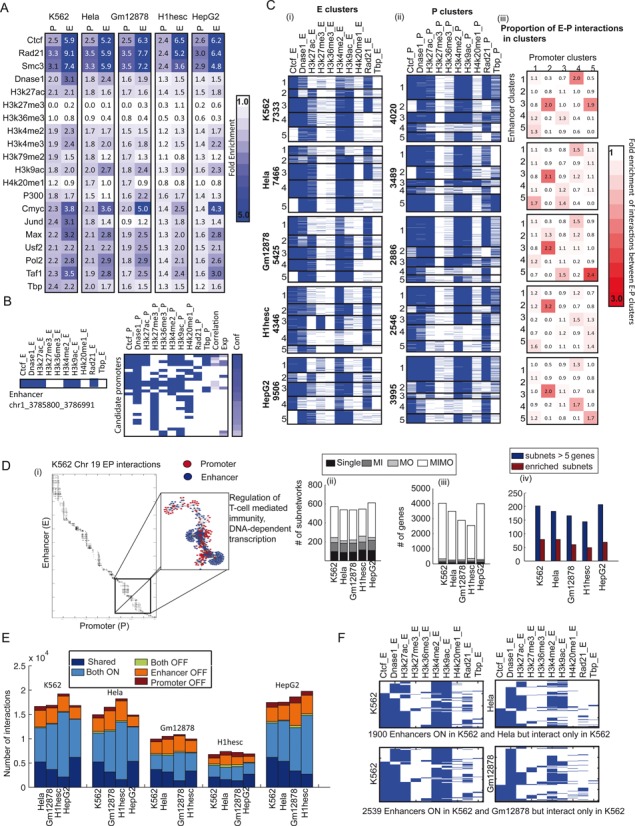
Properties of genome-wide enhancer-promoter interactions. (A) Enrichment of various individual genomic signals in the enhancers and promoters in the high confidence networks. The stronger the intensity of blue the better the enrichment. (B) Example of an enhancer from the K562 cell line and candidate promoters that are in its 1 MB radius. The promoters are ranked by RIPPLE confidence (Conf; min 0.5). The _E and _P features are binary (0: white, 1: blue), while the Correlation and Expression (Exp) features are continuous. (C) Clusters of enhancers and promoters in the five cell lines. (i) Enhancer clusters, each cluster is numbered 1–5, and the number of enhancers are shown on the side. (ii) Promoter clusters, numbered 1–5, with the number of promoters in each cluster shown on the side. Blue indicates the presence of a feature and white indicates absence. (iii) Fold enrichment of interactions between an enhancer cluster (row) to a promoter cluster (column) compared to the expected number of interactions between these clusters. The more red the intensity the greater is the tendency for enhancers from one cluster to interact with promoters from another cluster. (D) Enhancer-promoter interaction landscape for Chromosome 19 in K562. (i) The enhancer-promoter interactions for subnetworks extracted from a connected components analysis. The blow-up shows an example set of promoters regulated by multiple enhancers and enriched for transcriptional as well as immune response processes. (ii–iv), Distribution of enhancer-promoter interactions in different types of subnetworks. The majority of the interactions are in the multi-input multi-output subnetworks. Subnetworks are enriched in multiple GO processes, MSigDB gene sets and motifs. (E) Proportion of shared and different types of cell line-specific interactions. The same color convention is used as in Figure 3C. Comparison of regulatory signals in enhancers that interact in the K562 cell line but not in Hela (top), and similarly interact in K562 but not in Gm12878 (bottom). The blue color represents the presence of a particular signal in that region. The rows are sorted based on the entries in the first column (CTCF) followed by the second columns, etc (using MATLAB's sortrows function). Rows of each column maintain the ordering of the preceding columns.